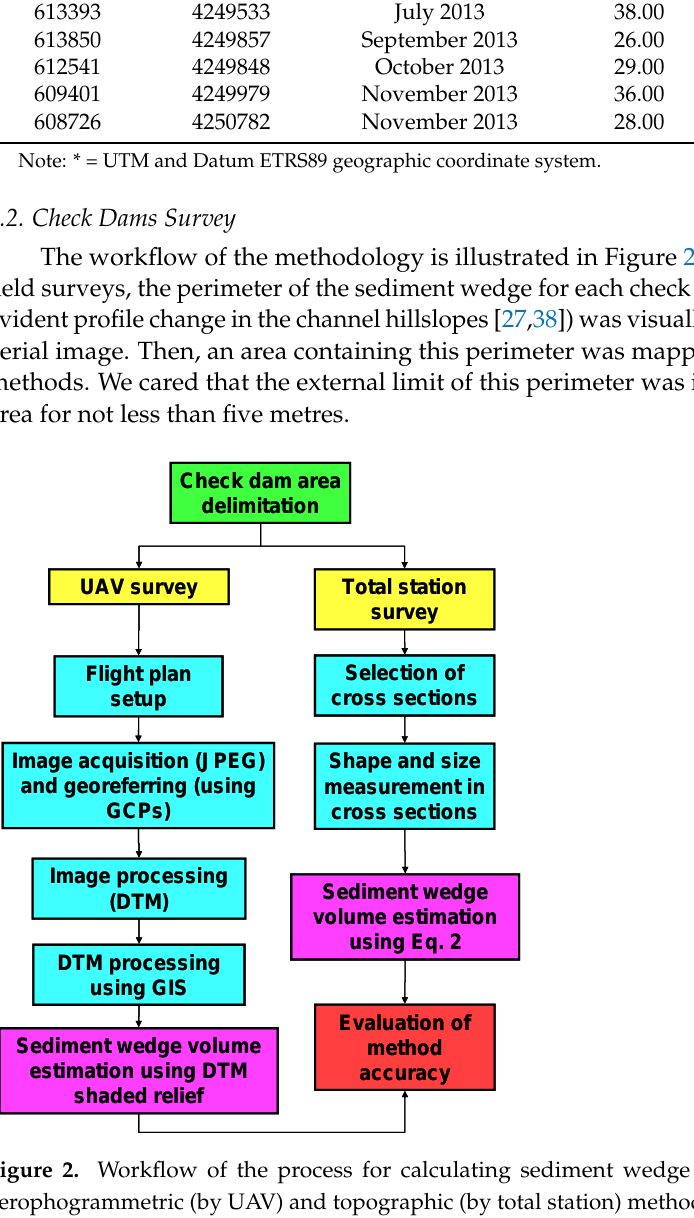
Table 1. Main characteristics of the ten check dams included in the post fire emergency restoration works in Sierra de Los Donceles forest by the government of Castilla-La Mancha Region (Spain).